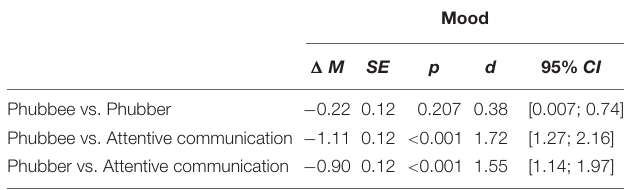
Mood (cid:49) M SE p d 95% CI